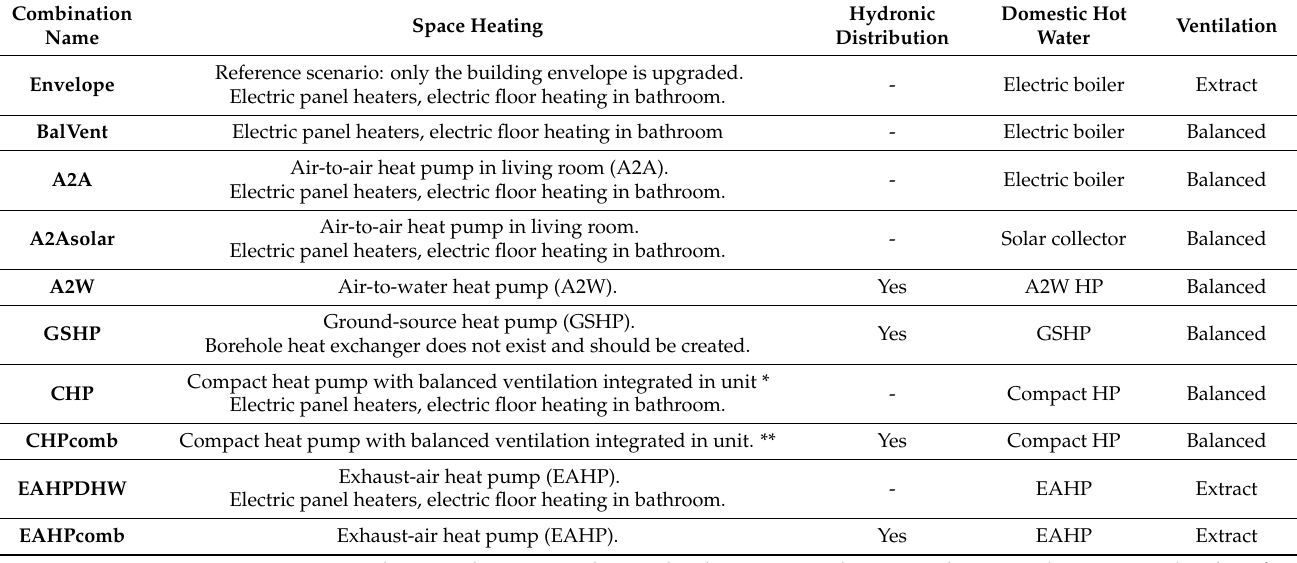
Table 3. Description of the different HVAC combinations: heat pump and ventilation